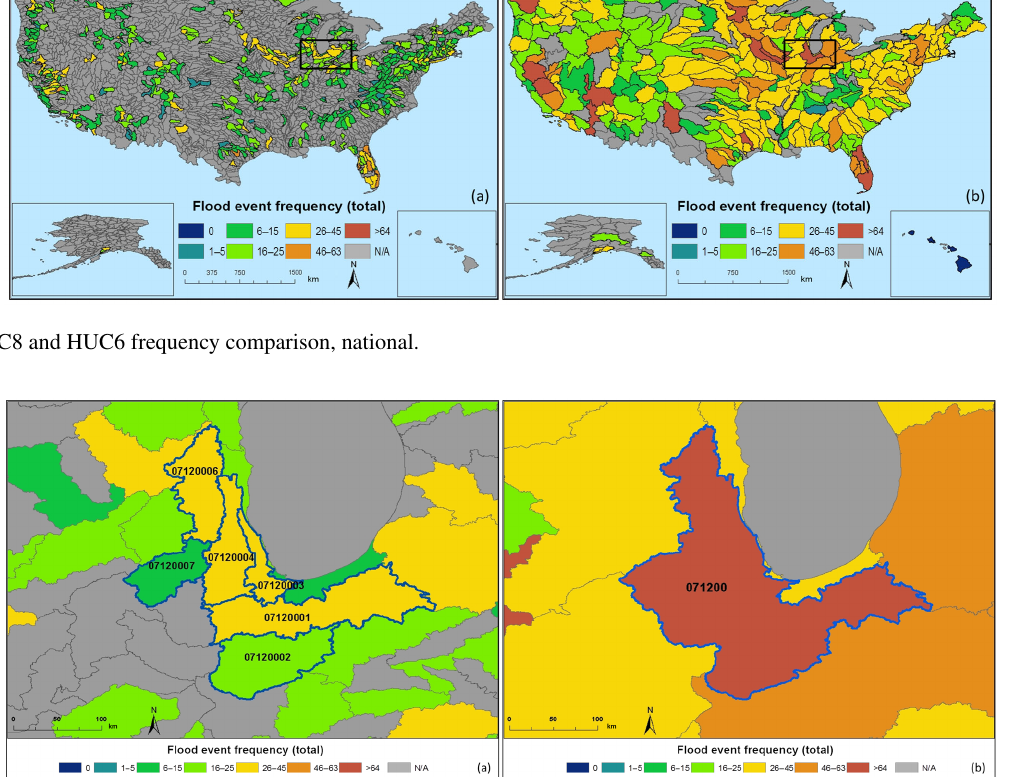
Figure 4. HUC8 and HUC6 frequency comparison, upper Midwest. Blue outline (HUC6: 071200, HUC8: 07120001–07120007).